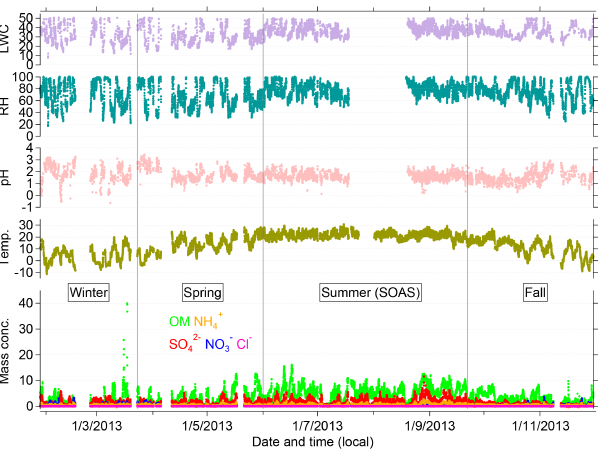
Figure 1. Annual temporal variations of OA and inorganic species (µgm − 3 ) measured at the Jefferson Street (JST) site, Atlanta, Geor- gia, in 2012. Included in the plots are ambient temperature ( ◦ C) and relative humidity (RH, in %) measured by SEARCH network, as well as pH and liquid water content (LWC, in molL − 1 ) estimated by ISORROPIA-II.